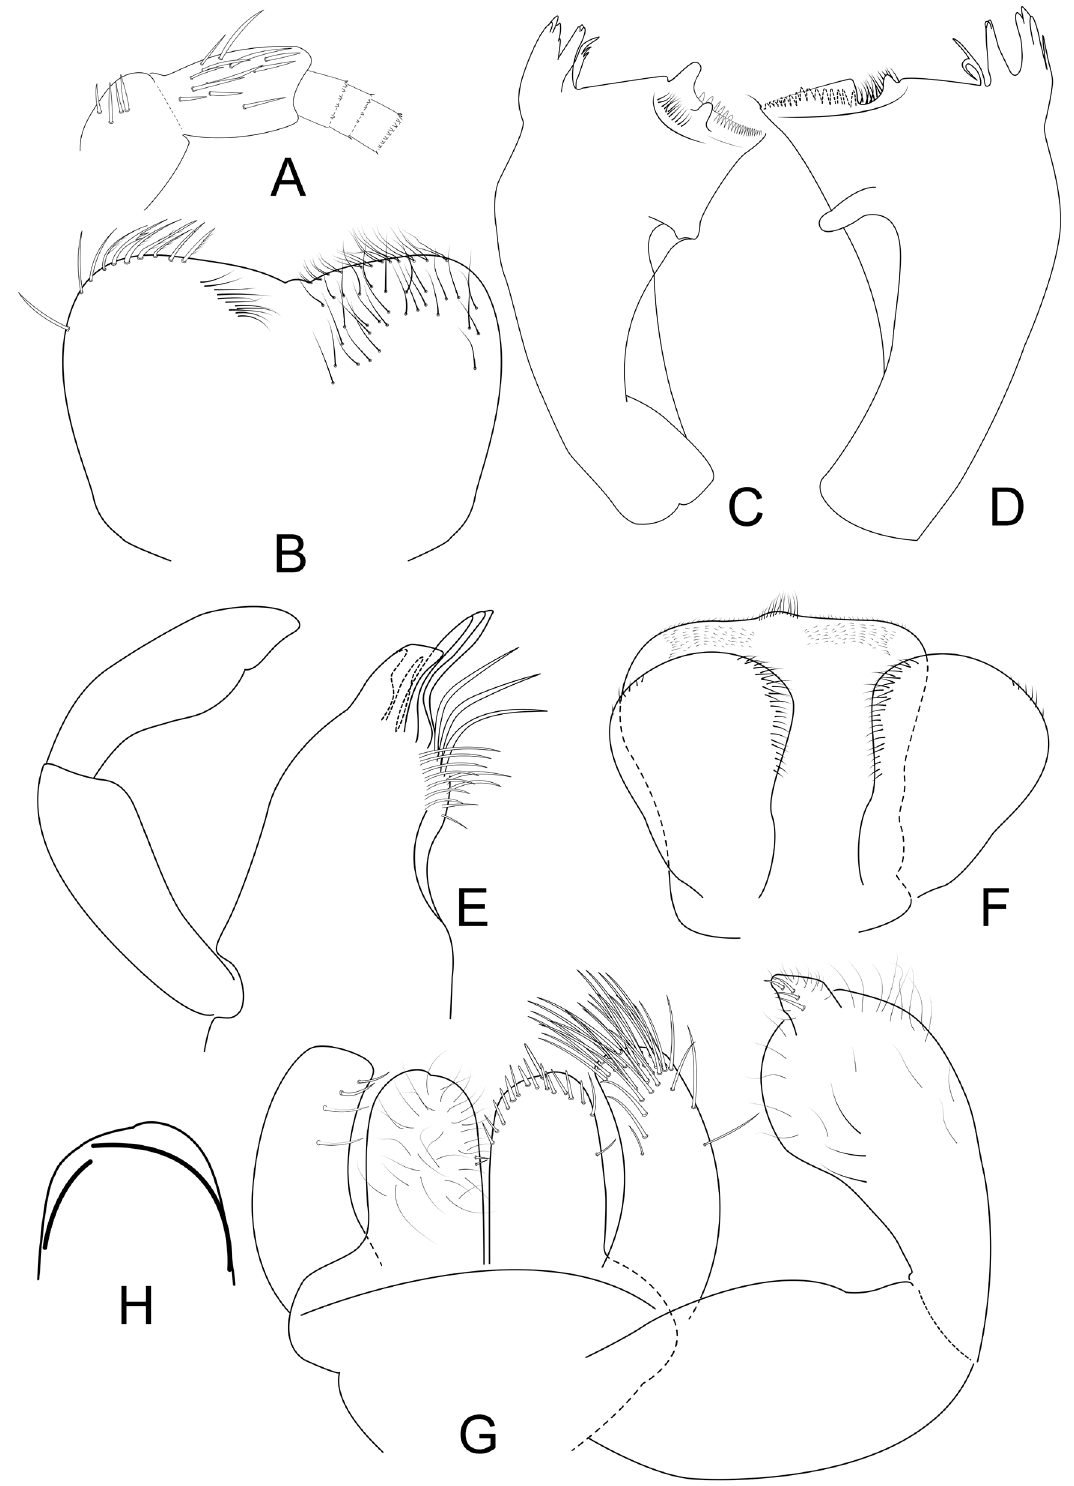
Fig. 1. Rivudiva trichobasis Lugo-Ortiz & McCafferty, 1998, paratype (IBN slide #270). A . Scape and pedicel. B . Labrum (left v.v., right d.v.). C . Left mandible. D . Right mandible. E . Apex of maxilla (base was deformed in slide). F . Hypopharynx. G . Labium (left v.v., right d.v.). H . Shape of distal rows of setae of glossa. Not to